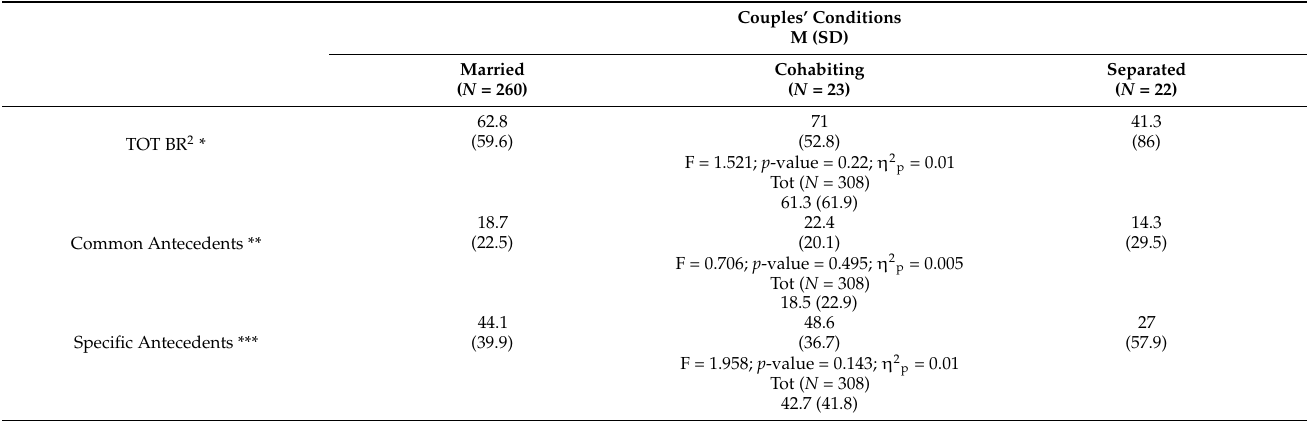
Table 5. Parental distress descriptive data for couples’ conditions.